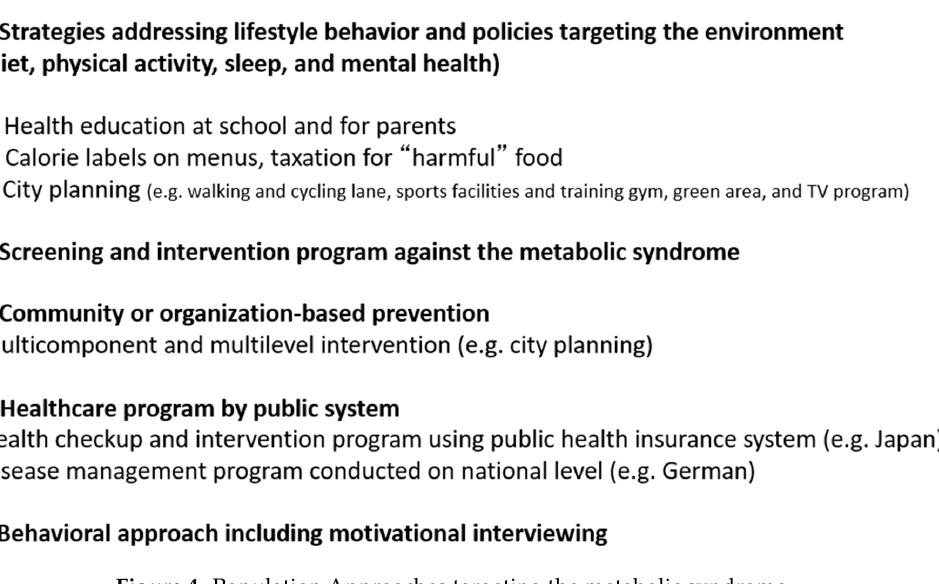
Figure 4. Population Approaches targeting the metabolic syndrome.